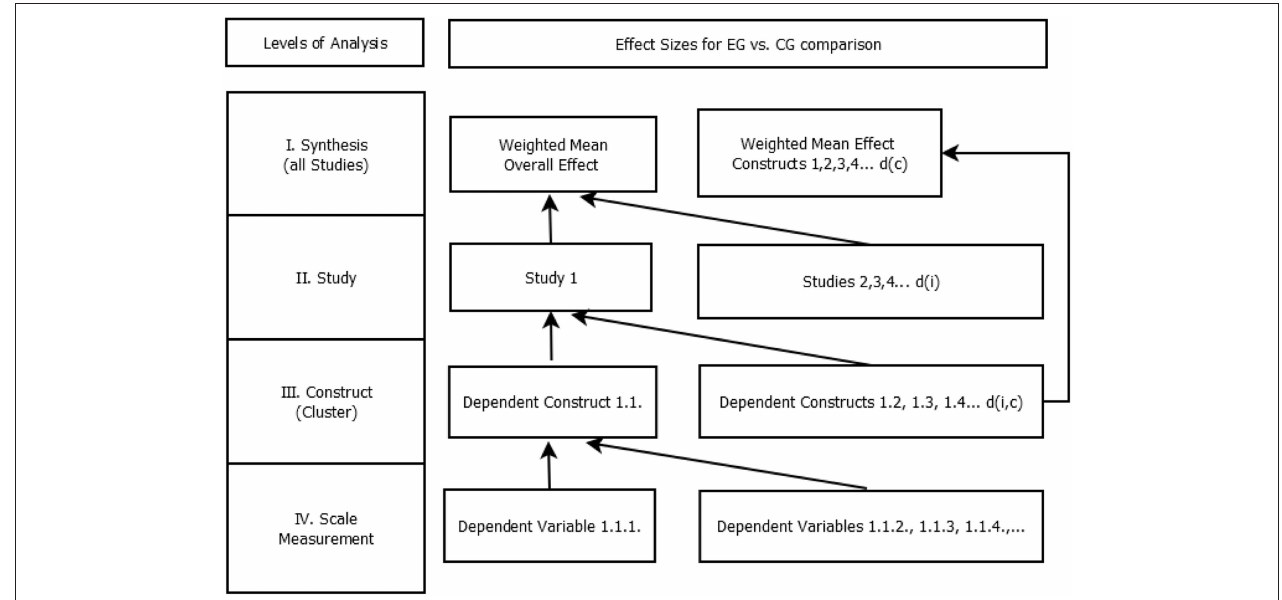
FIGURE 2 | Hierarchy of effect sizes. EG, experimental group; CG, control group; d(c), weighted mean effect size per cluster; d(i), weighted mean effect size per study; d(i,c), weighted mean effect size per cluster within one